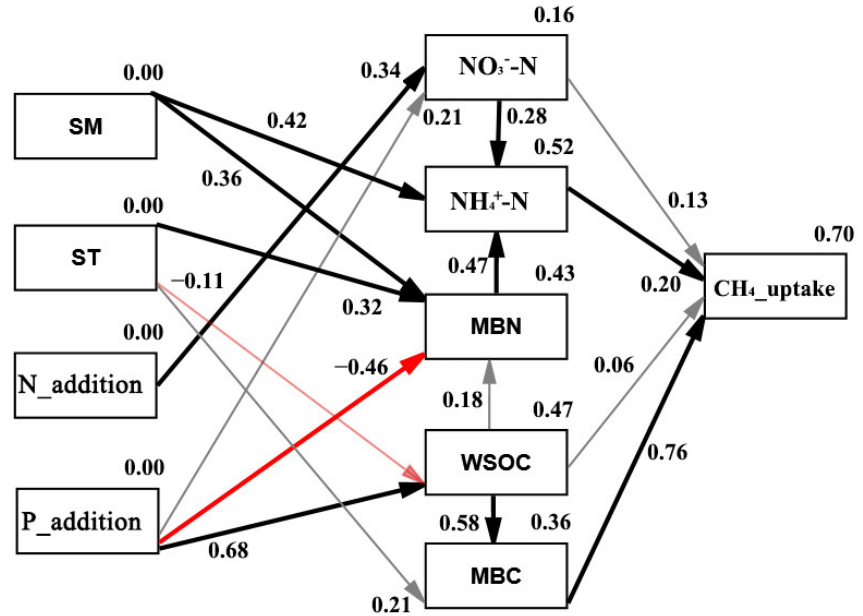
Figure 5. The structural equation model explaining the direct and indirect effects of N and P additions and soil properties on soil CH 4 uptakes across all treatments. The SEM model parameters: χ 2 = 15.27, df = 25, RMSEA = 0.000 and GFI = 0.93. Black and wide arrows indicate significant positive relationships and red arrows indicate significant negative relationships ( p < 0.05). The thin and light-colored arrows indicate insignificant effects. Numbers on arrows are standardized path coefficients. The width of an arrow indicates the relative strength of the causal